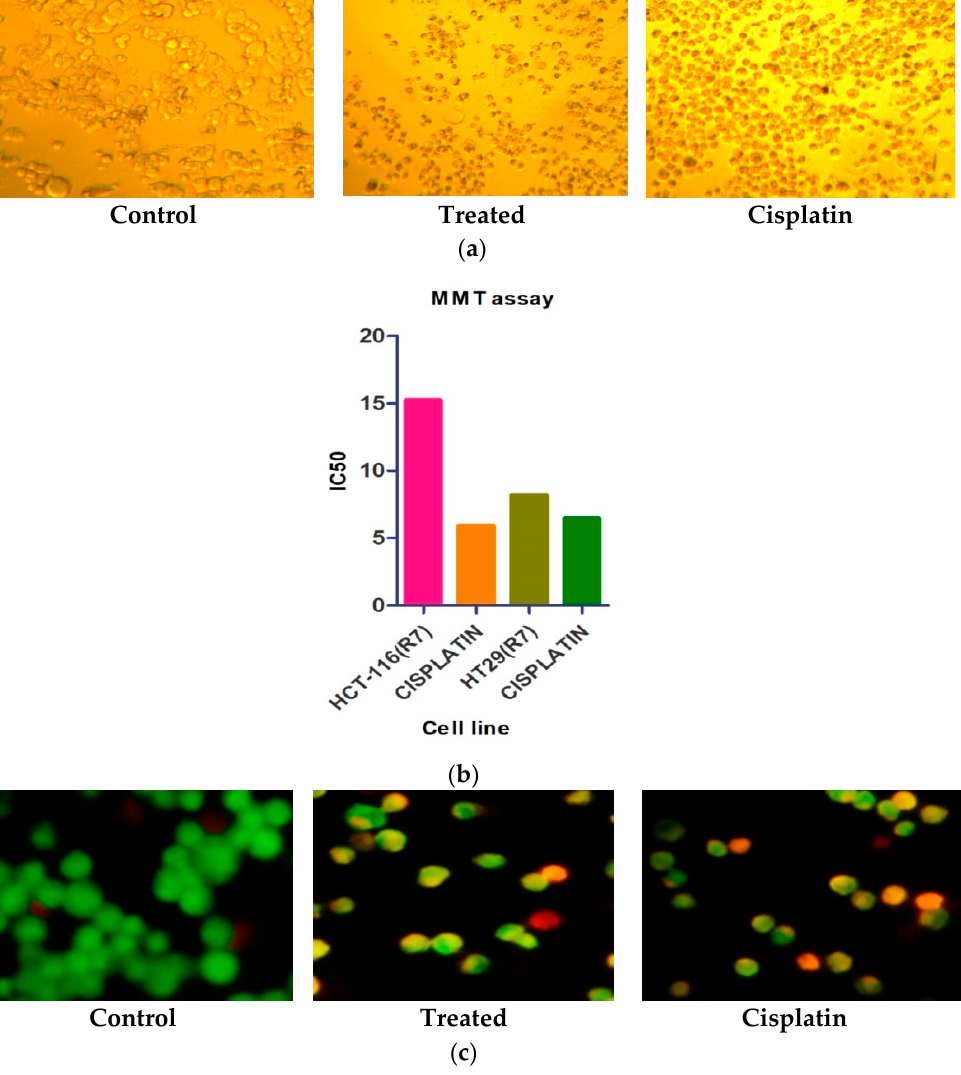
Figure 2. ( a ) The morphological changes in HT-29 cells in control, treated and cisplatin with specified concentration was observed and visualized under light microscope. ( b ) the IC 50 of RB-7 on different human cancer cell lines along with cisplatin as a standard drug. ( c ) Apoptosis inducing-activity of RB7 by AO/EB staining for specific cell line HT-29 in RB7 with 8.18 µM concentration.